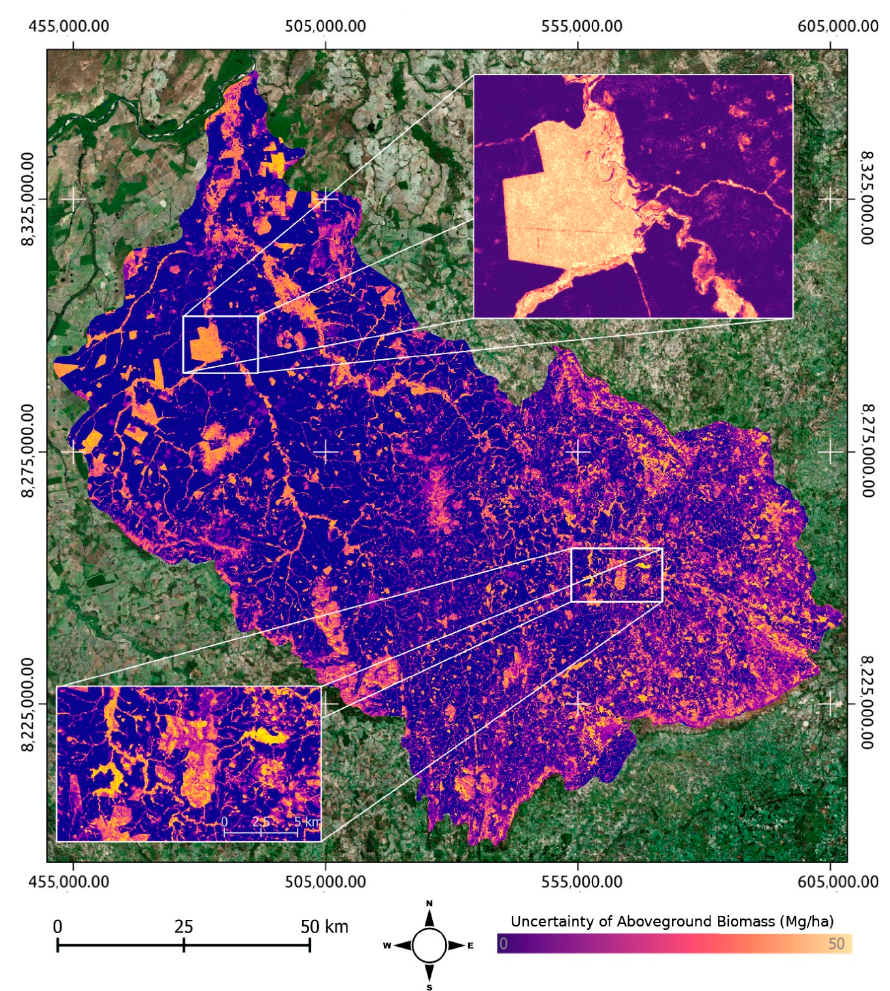
Figure 4. Error map (30-m resolution) for the Rio Vermelho watershed in the Brazilian Cerrado. Zooms on the top right and bottom left of the figure show the details of the variations of the AGB uncertainty between the different types of forest formations in the study area. Background image: © Bing™ aerial photo. Screenshot(s) reprinted with permission from Microsoft™ Corporation. Remote Sens. 2020 , 11 , x FOR PEER REVIEW